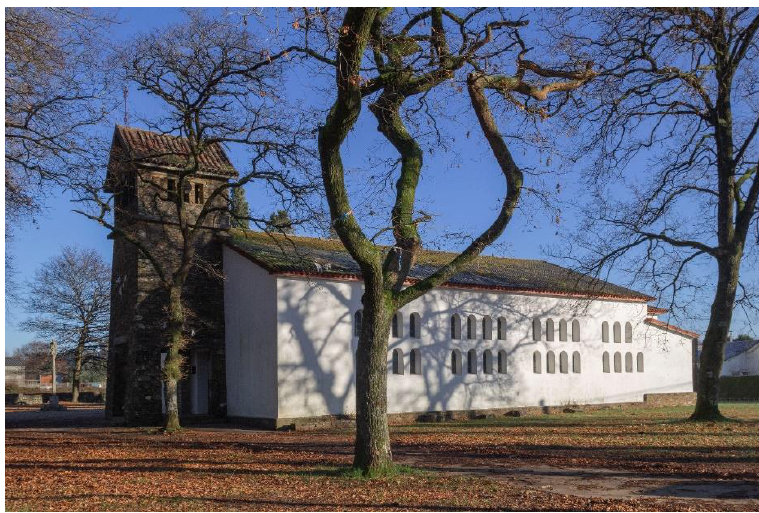
Figure 2. Parish Church Santa María de Deixebre (Deixebre-Oroso, A Coruña, 1963), by Milagros Rey Hombre. Photo credit: María Novas.